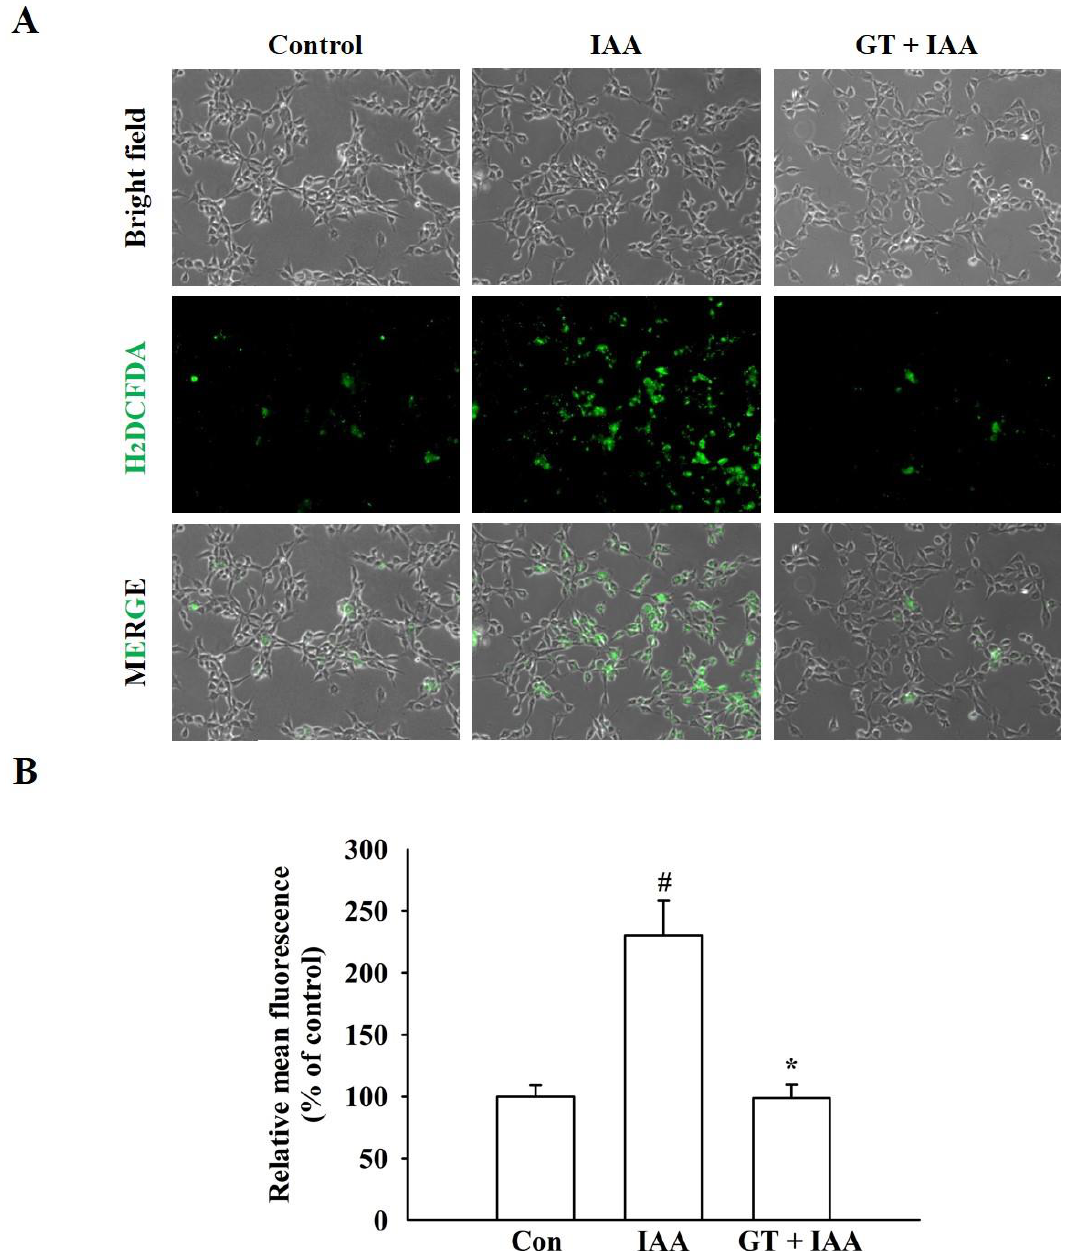
Figure 2. Effect of gintonin on IAA-mediated ROS accumulation in HT22 cells. ( A ) Representative images of CM-H2DCFDA staining. HT22 cells were pretreated with or without gintonin (3 µ g/mL) for 1 h, washed, and treated with 5 µ M IAA for another 2 h. The cells were exposed to CM-H2DCFDA (10 µ M) for 30 min. Microscopy images were captured at the same magnification, scale bar = 100 µ m. ( B ) Quantitative analysis of the images obtained from fluorescence microscopy. The data are represented as the mean ± standard error of the mean (SEM; n = 4). # p < 0.01 compared to the control group; * p < 0.01 compared to the IAA alone-treated group.